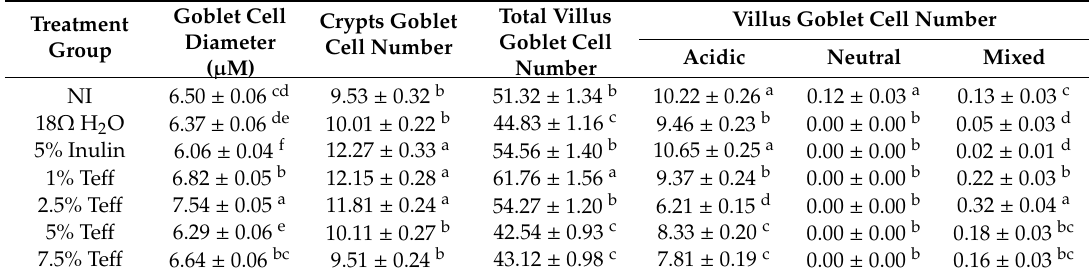
Table 9. E ff ect of the intra-amniotic administration of experimental te ff solutions on duodenal goblet cells 1